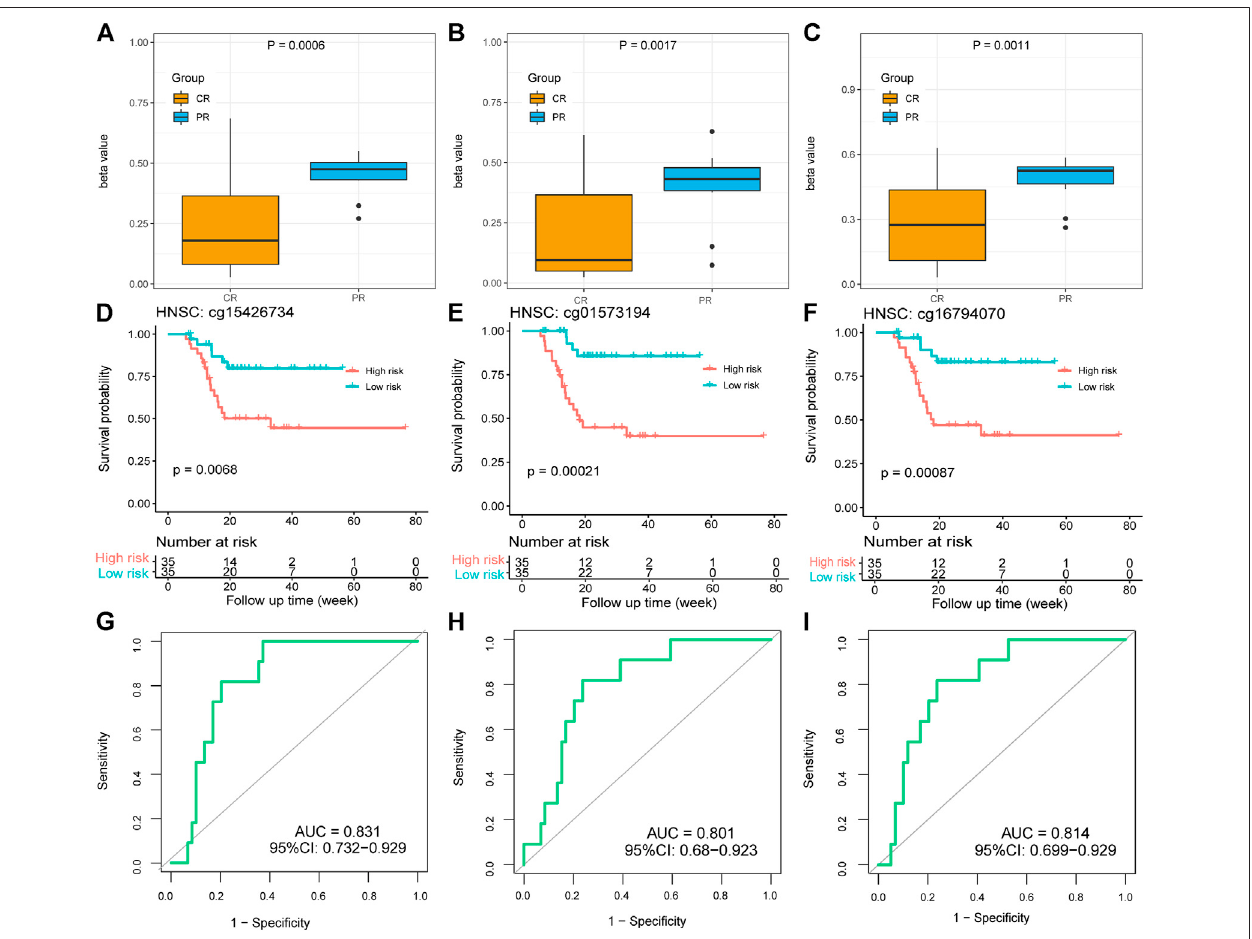
FIGURE 6 | Methylation and clinical values of PARD6A in platinum-treated patients with HNSC. (A – C) Different beta values of cg15426734, cg01573194, and cg16794070 between the CR and PR groups in HNSC. p values were calculated using the Wilcoxon test. (D – F) K-M survival plots grouped by the beta values of cg15426734, cg01573194, and cg16794070 in HNSC. p values were directly calculated using log-rank test. (G – I) ROC curves of the three